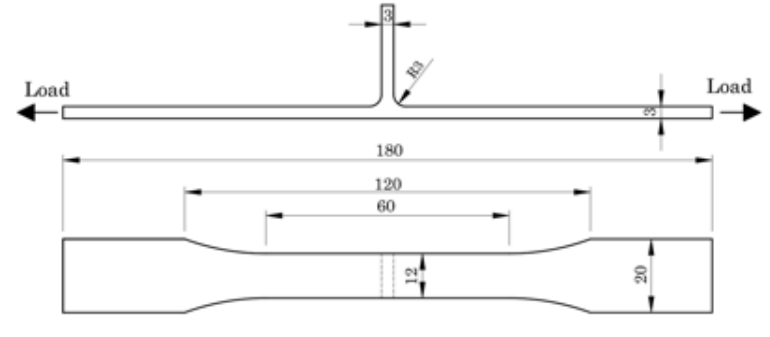
Figure 2. Fatigue specimen—shape and size.